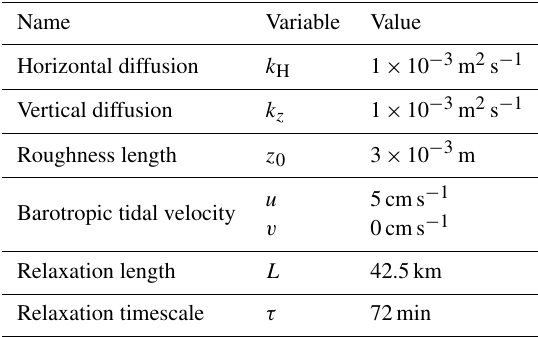
Table 2. Inputs of COMODO-revised